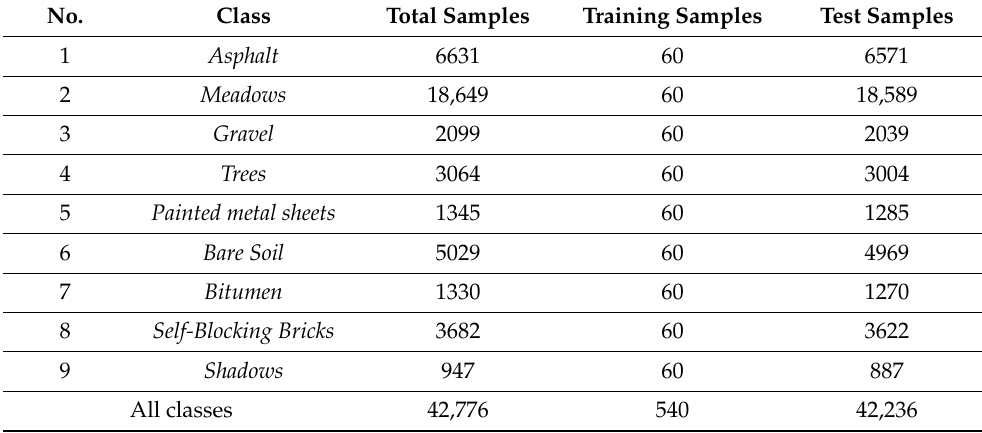
Table 1. Land cover classes and division of samples in the hyperspectral